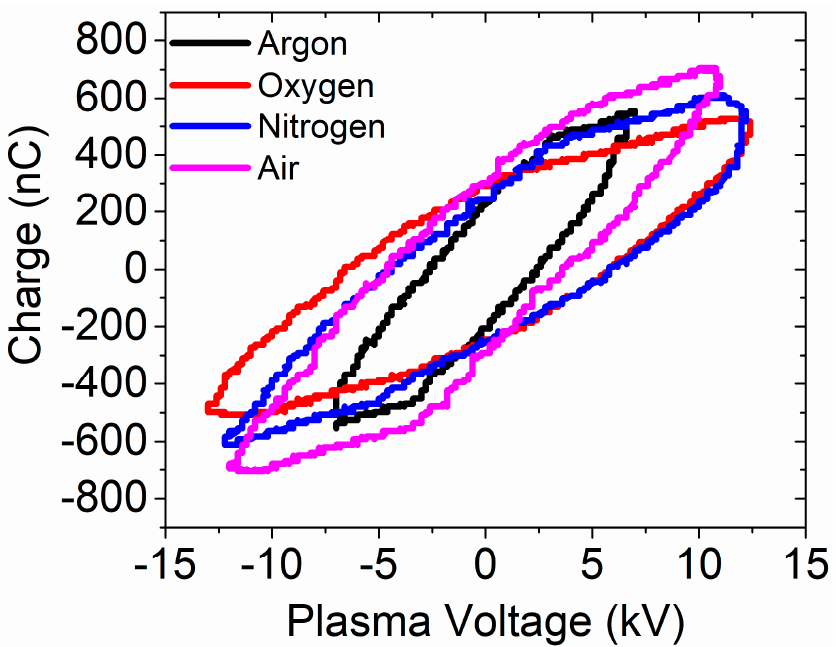
Figure 2. Lissajous plot for air, nitrogen, oxygen, and argon DBD plasmas to calculate the consumed energy and